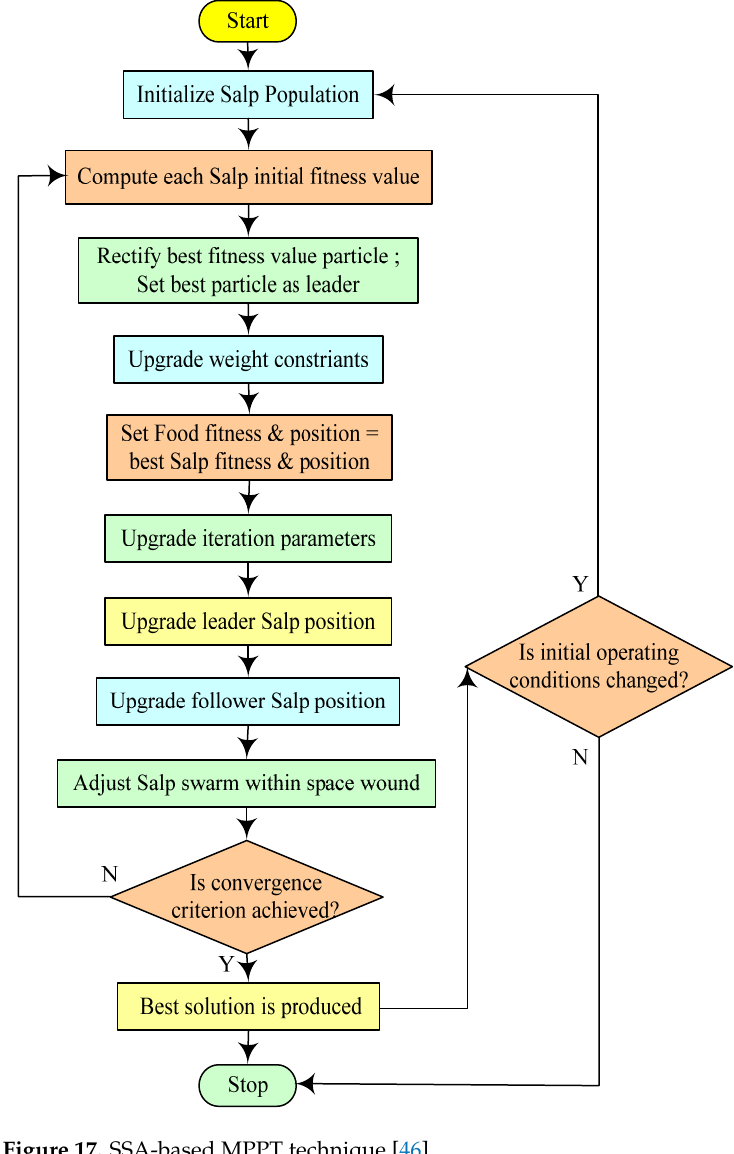
Figure 17. SSA-based MPPT technique [46].